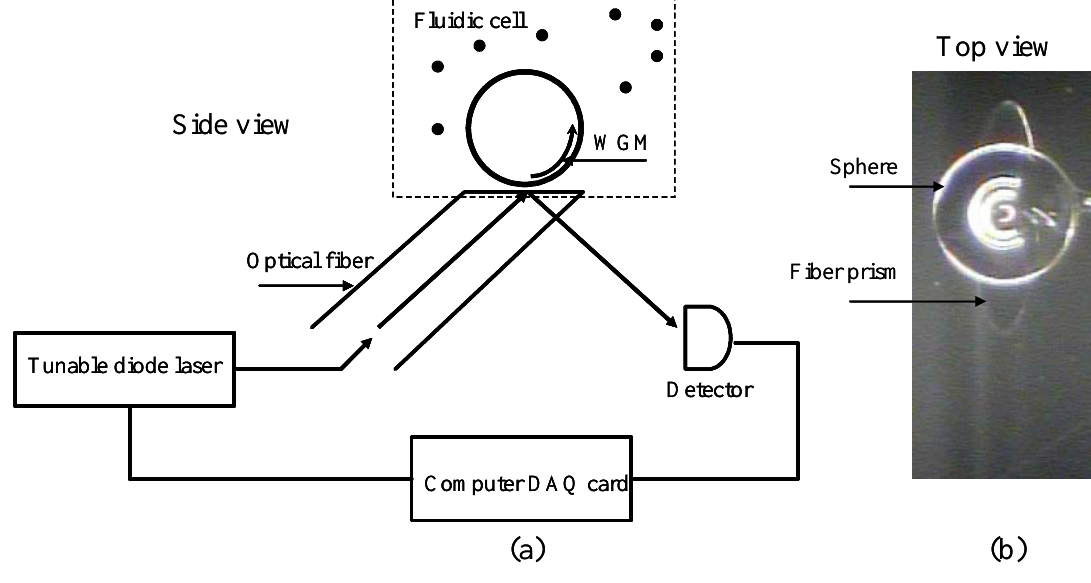
Figure 1 . Experimental setup. (a) The sphere is immersed in a fluidic cell and in physical contact with a fiber prism. A tunable diode laser at 980 nm is coupled into the WGM of the sphere via frustrated total internal reflection at the sphere-prism interface. The laser is repeatedly scanned in wavelength and controlled by a computer DAQ card. (b) Image of a fiber prism with a fused silica microsphere.